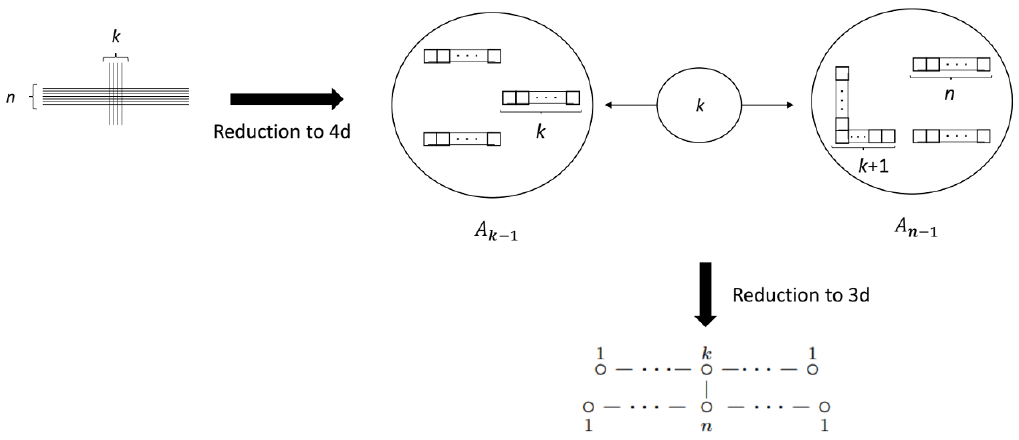
Figure 2 . Starting with the 5d SCFT described by the brane web in the top left, and reducing to 4d, it is conjectured by [48] that we get the 4d theory on the top right, where here we take n > k . The small circle denotes an SU( k ) group and the arrows indicates it is gauging an SU( k ) global symmetry in both class S theories. Reducing further to 3d leads to the mirror quiver on the bottom.